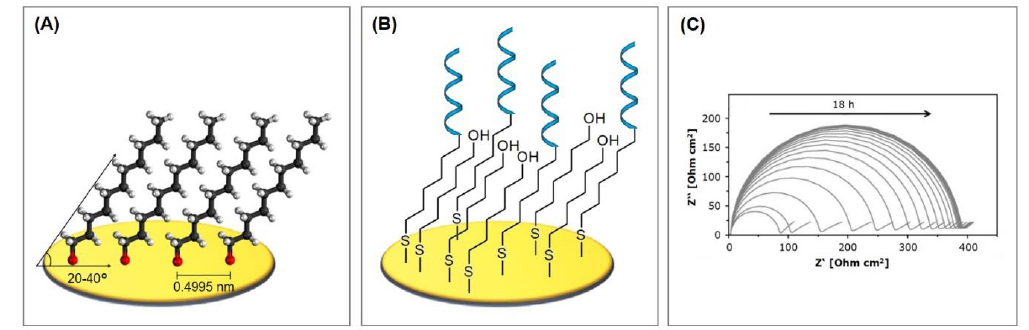
Figure 3. Characteristics of alkanethiol self-assembled monolayers. ( A ) Self-assembled monolayer of alkanethiols, based on [18]. ( B ) Typical biosensor setup consisting of thiolated aptamers and mercaptohexanol (MCH). ( C ) Process of gradual reorganization in alkanethiol monolayers. Xu et al. [30] observed an increasing diameter of the semicircle in the Nyquist plot and therefore a drift of the calculated charge transfer resistance over a period of 18 h after the backfilling with MCH. Reproduced with permission from Xu et al. [30], copyright 2019, American Chemical Society.